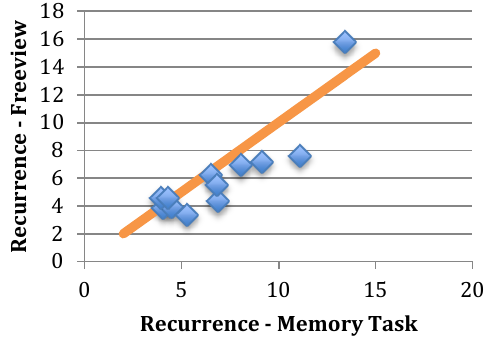
Figure 11 : Recurrence values for observers who free- viewed twelve paintings of various complexity and abstraction relative to observers who were told that they would be asked questions about the content of the paintings. The line defines where recurrence for observers free viewing images would match those tasked with remembering the image